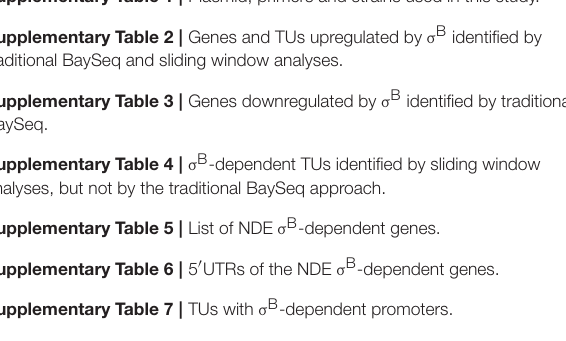
Supplementary Table 1 | Plasmid, primers and strains used in this study.